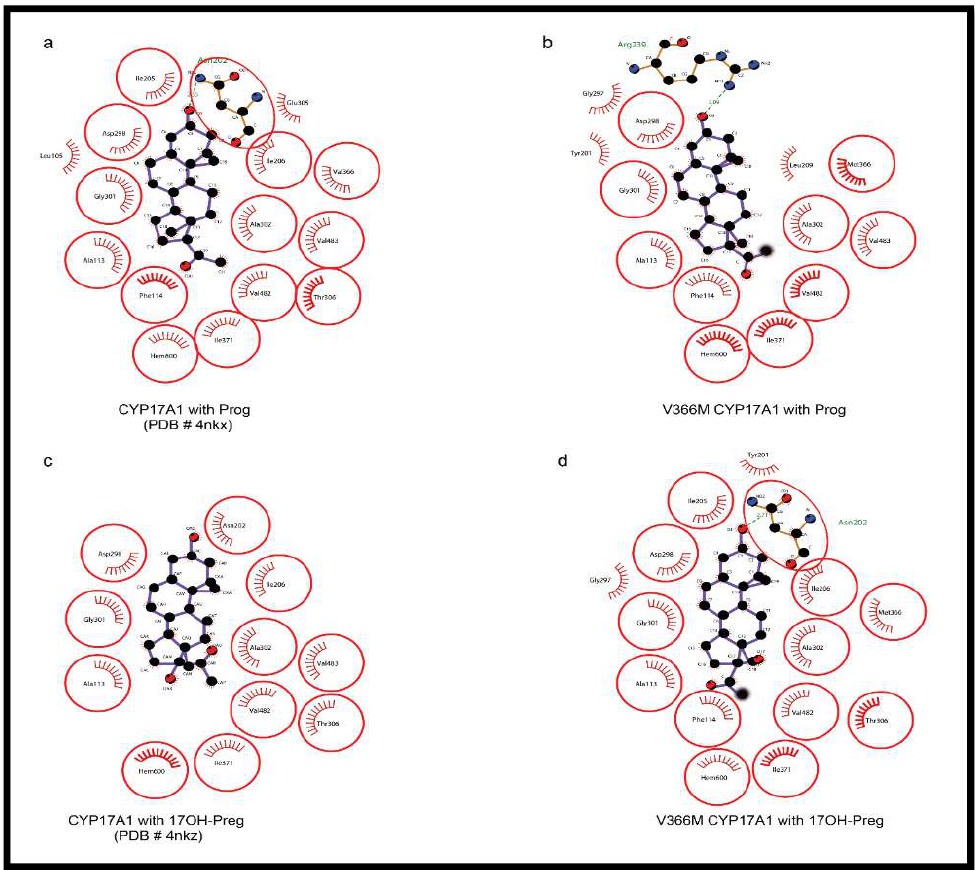
Figure 9. Comparison of PROG and 17OH-PREG bound in crystal structures of human CYP17A1 with the docked steroids into the V366M mutant. ( a , b ) PROG is found to bind similarly to WT as well as the mutant enzyme. ( c , d ) Mutation of V366 to M leads to non-optimal interactions with the N202 group in the V366M mutant compared to WT where this interaction is absent in poses which have 17OH-PREG close to the heme.